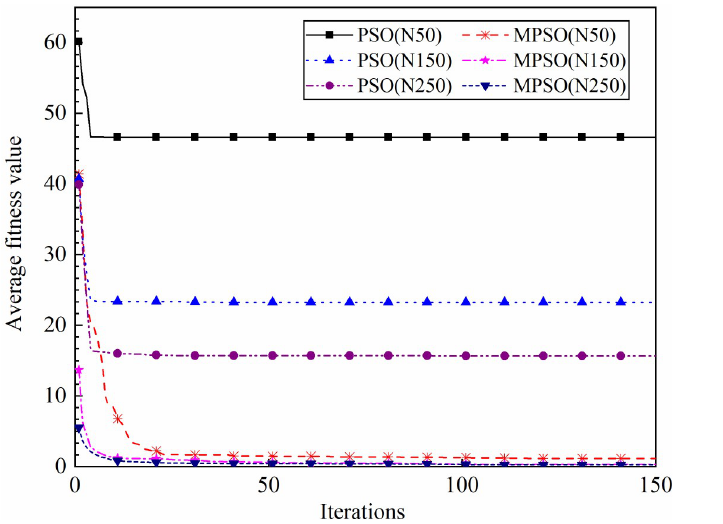
Fig 7. Iterative results of PSO and MPSO